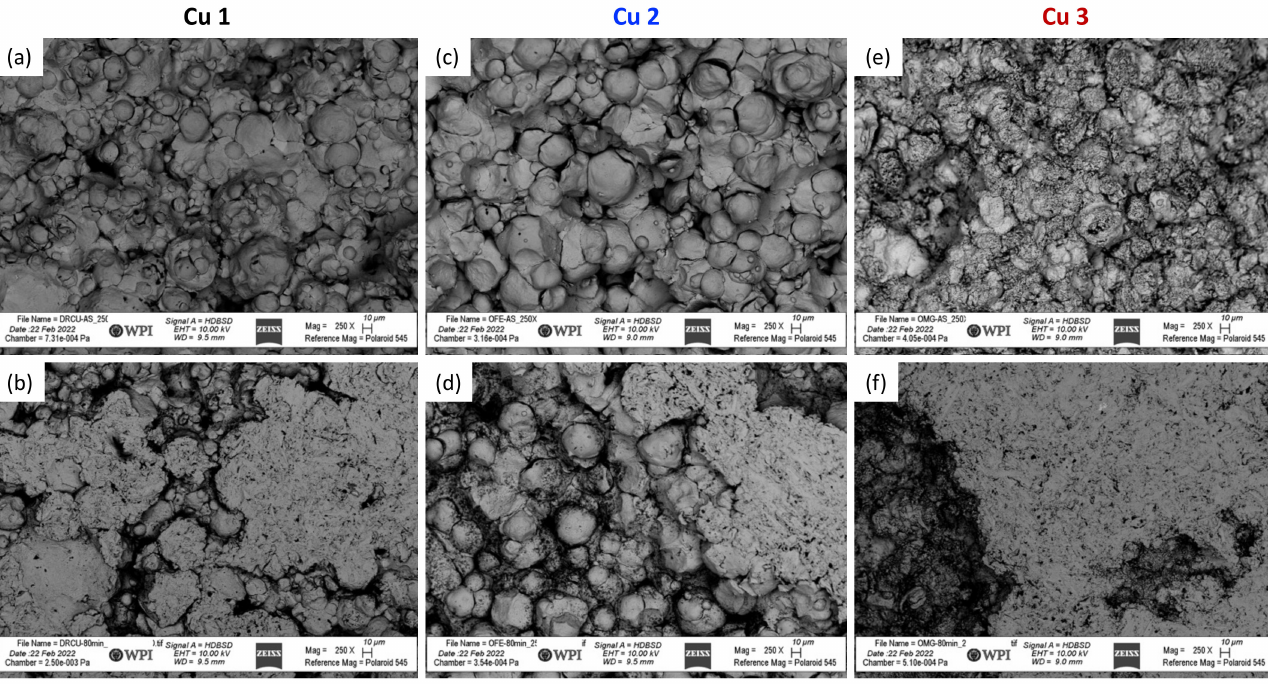
Figure 7. ( a , c , e ) present SEM micrographs of the as-sprayed Cu 1, Cu 2, and Cu 3 cold sprayed material consolidations, respectively. Similarly, ( b , d , f ) present SEM micrographs of the Cu 1, Cu 2, and Cu 3 cold sprayed material consolidations, respectively, following the application of mass finishing for 80 min. Note that ( b , d , f ) were captured from regions of the modified surfaces that were along the interfacial or transitional zones between the smooth islands and rough valleys previously